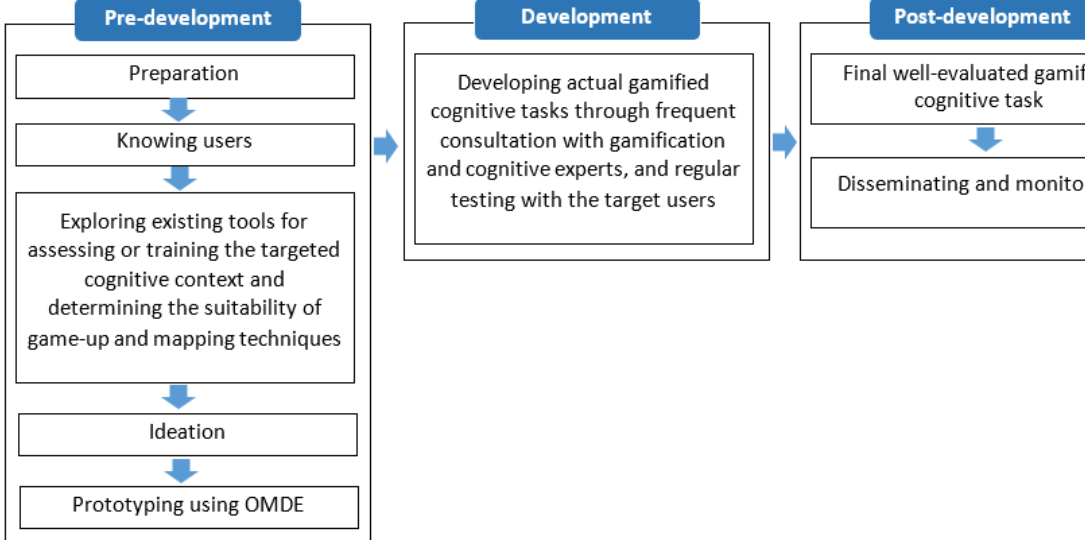
Figure 4. The proposed framework. OMDE: Objects, Mechanics, Dynamics,